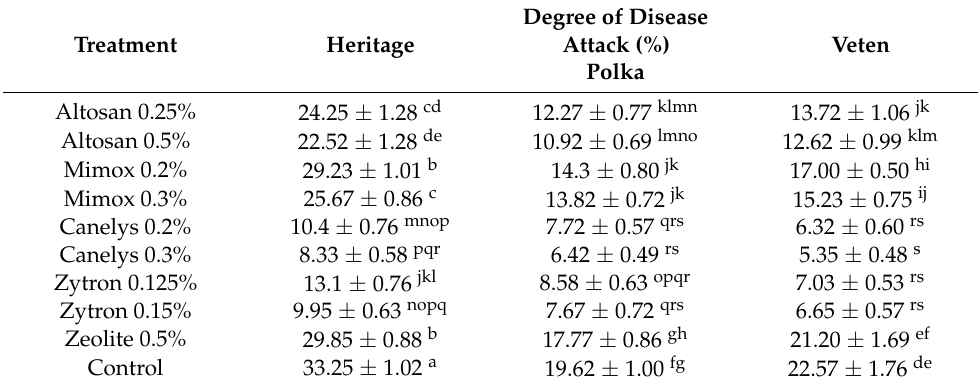
Table 11. Organic control of rust disease severity in three raspberry varieties during 2018–2019. Degree of Treatment Heritage